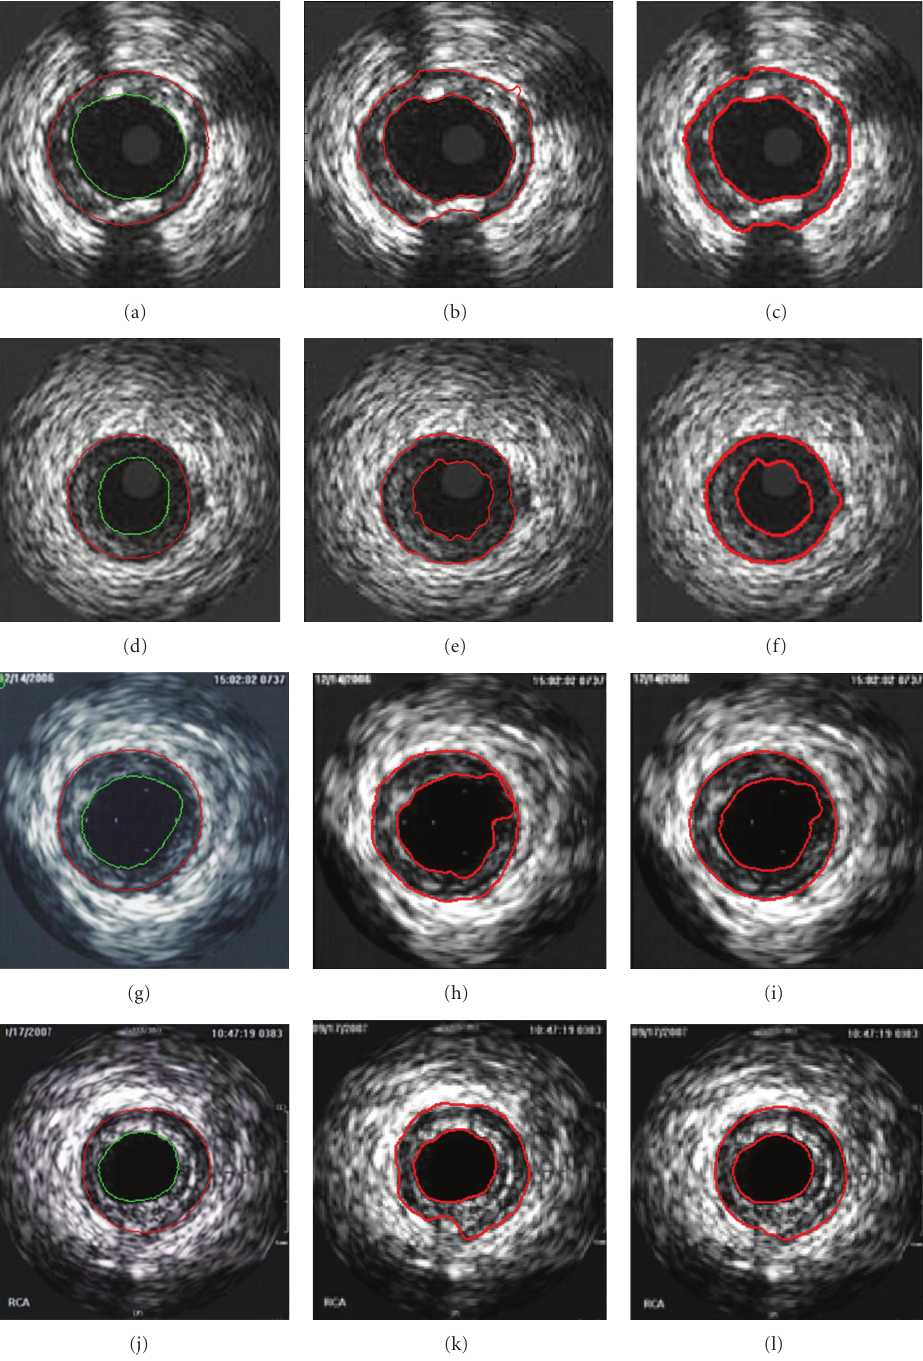
Figure 5: Three examples of real images segmentation results. ((a), (d), (g), (j)) Real boundaries (ground truth), ((b), (e), (h), (k)) traditional level-set model, and ((c), (f), (i), (l)) the proposed method.